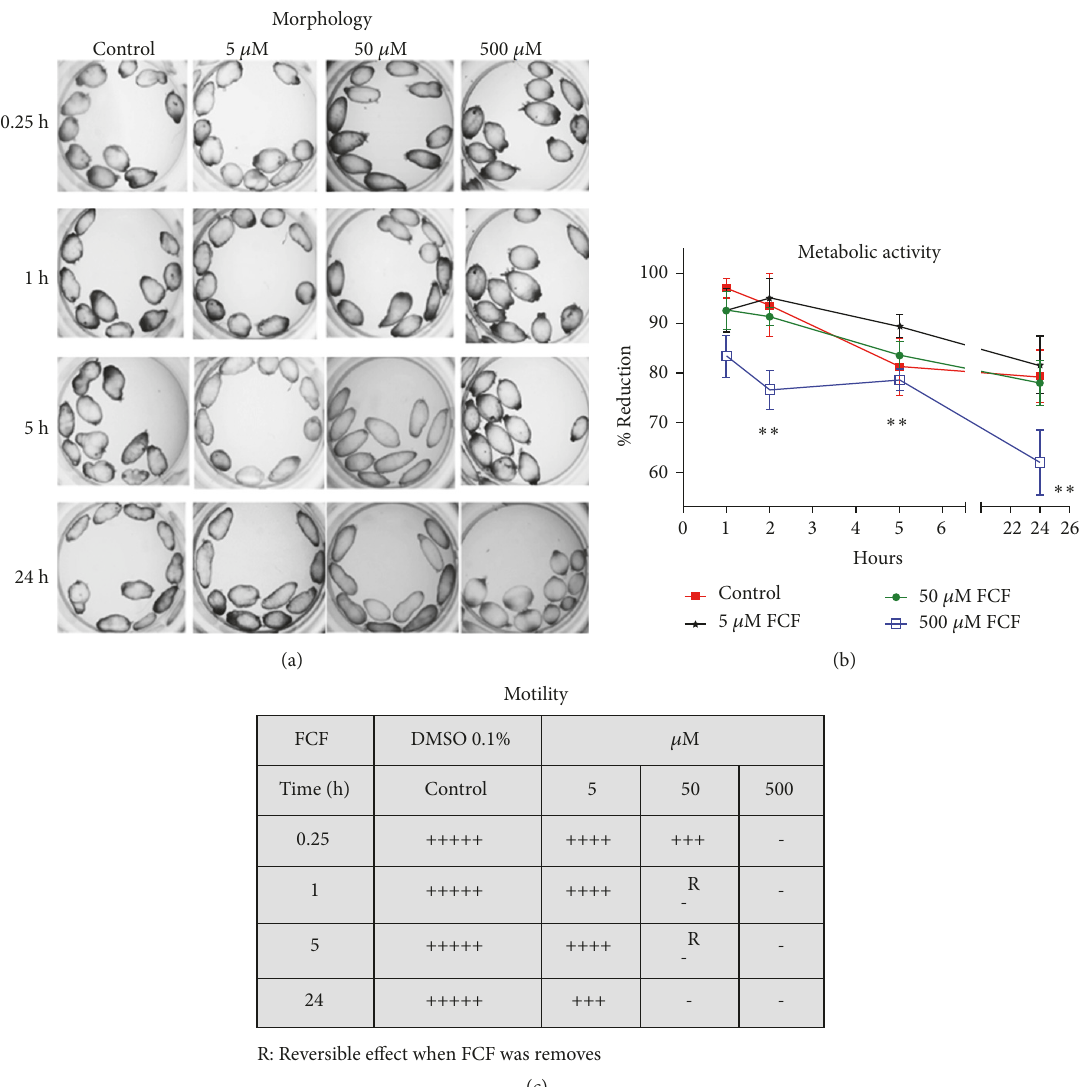
Figure 1: In vitro evaluation of the effect of FCF on T. crassiceps cysticerci. (a) Changes in the morphology of cysticerci were detected by stereomicroscopy, using three concentrations of FCF (5, 50, and 500 𝜇 M) at four different times (0.25, 1, 5, and 24 h). (b) Changes in metabolic activity were measured by the reduction of Alamar blue (cid:2) (Y-axis) over a period of 24 h (X-axis). (c) Table summarizing the effect of FCF on parasite motility, where R represents the reversibility of changes in motility under these